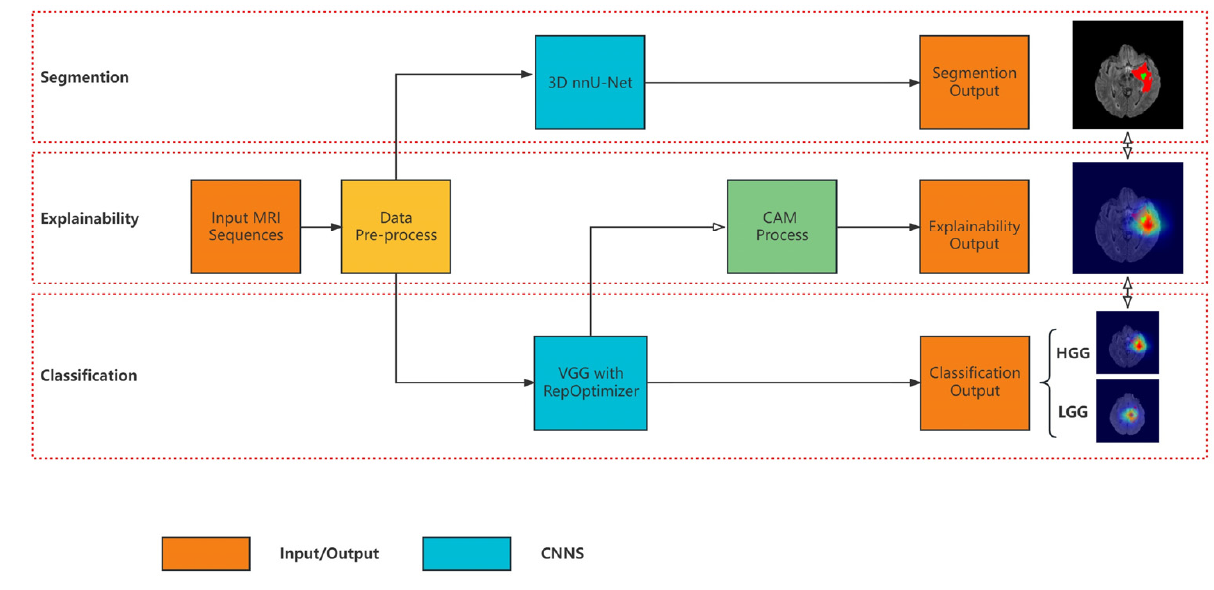
Figure 1. Overall explainable framework of brain tumor detection. The three parts of the framework include: segmentation, classification, and explainability.